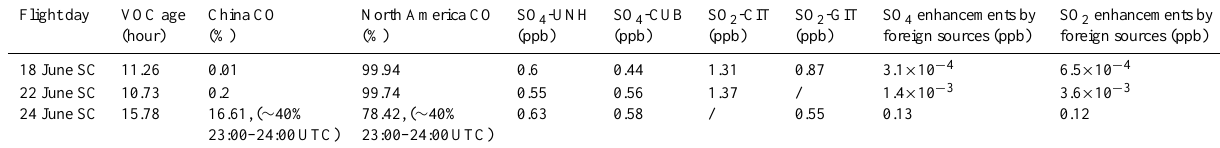
Table 5. Air-mass properties below 1km a.s.l. along three SC flight paths from observations and tracer calculations. Flight